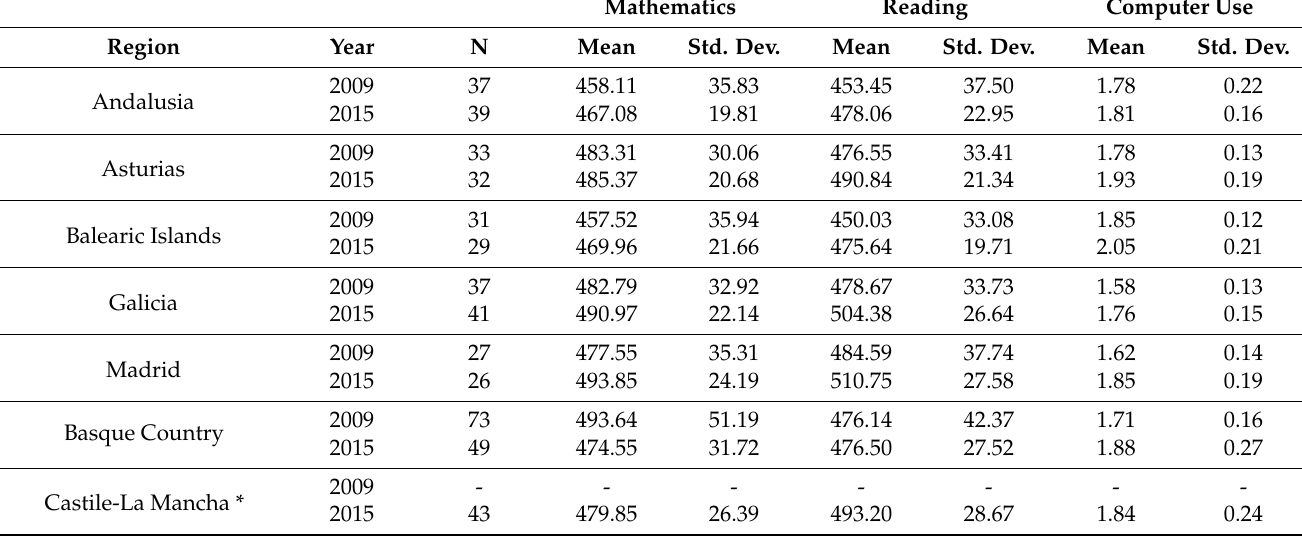
Table 1. School sample and average PISA scores in mathematics, reading, and computer skills by year and